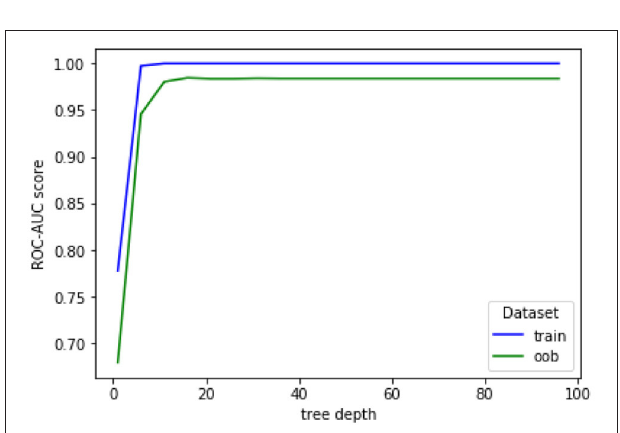
FIGURE 7 | Evolution of AUC-ROC for training and out-of-bag (oob) sets as a function of tree